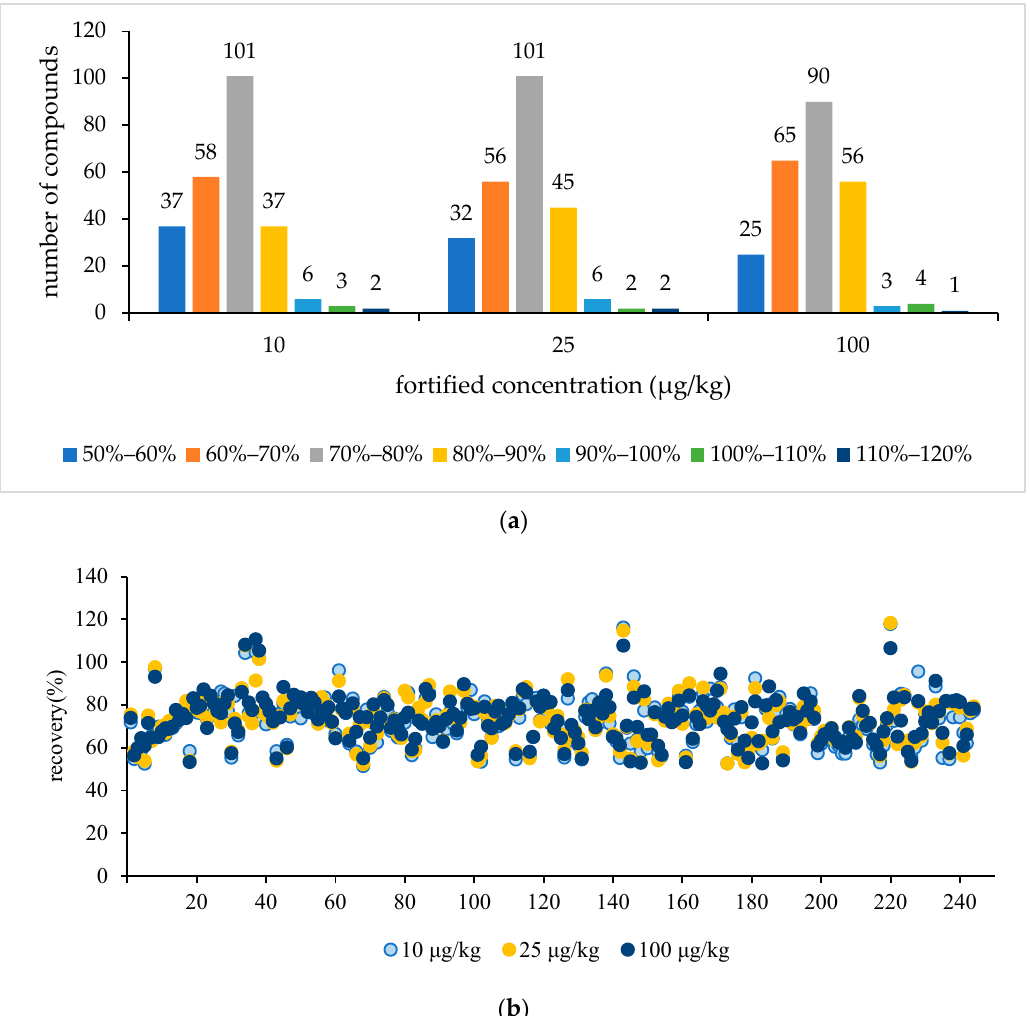
Figure 5. Distribution of recovery at the fortified concentrations of 10, 25 and 100 µ g kg − 1 . ( a ) Number of compounds in recovery ranges at the fortified concentrations of 10, 25 and 100 µ g kg − 1 ; ( b ) Trends of recoveries at the fortified concentrations of 10, 25 and 100 μ g kg − 1.